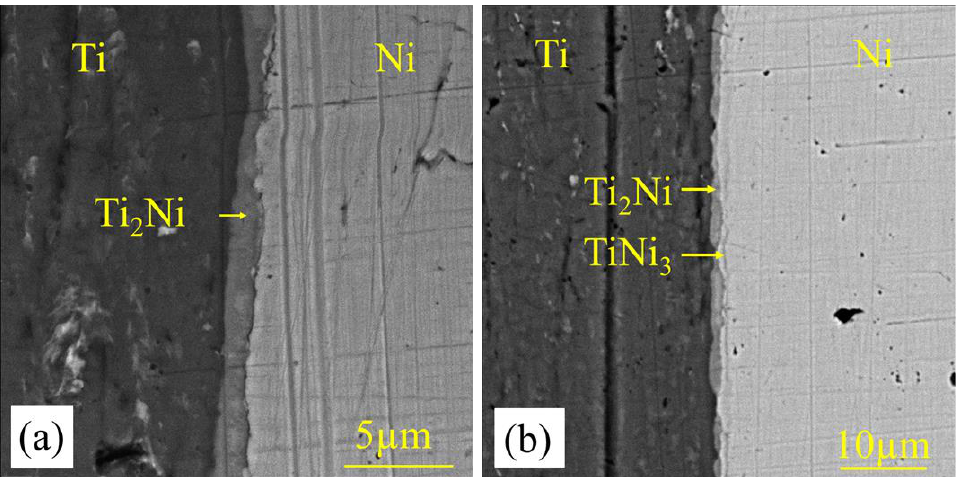
Figure 3. SEM micrographs at the interface of the Ti – Ni diffusion couple annealed at 900 °C for ( a ) 1 min and ( b ) 5 min.